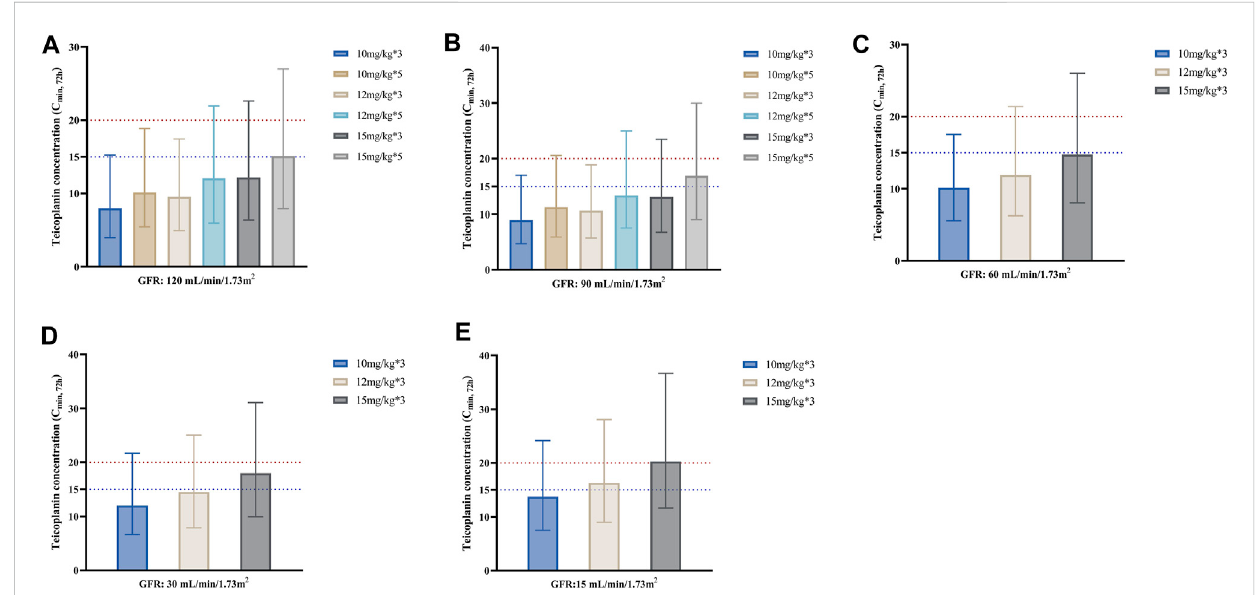
FIGURE 3 Median teicoplanin C min, 72h with different loading doses in subgroups strati fi ed by GFR. (A – E) represent subgroups with GFR of 120, 90, 60, 30 and 15 mL/min/1.73m 2 ,respectively.Eachbarrepresentsthemedianwitha95%percentileinterval(PI).Loadingdoseswereadministeredevery12 h,andC min was simulated by day 4(72 h). The dashed blue and red lines indicate thetarget C min of 15 mg/L (non-complicated infections) and 20 mg/L (complicated infections),